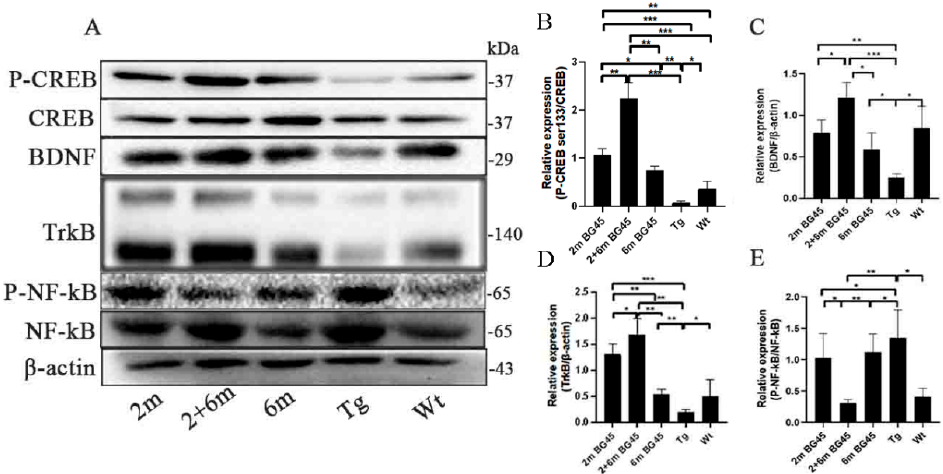
Figure 8. BG45 improved the expression of CREB/BDNF and inhibited p-NF-kB in the entorhinal cortexes of the APP/PS1 mice. ( A ) Representative protein expression bands of the CREB/BDNF/NF- kB pathway. ( B – E ) Quantitative statistical analysis of the related proteins in the entorhinal cortex samples. All values are presented as the means ± SDs from three independent experiments. *** p < 0.001, ** p < 0.01, and * p < 0.05. n = five mice per group.